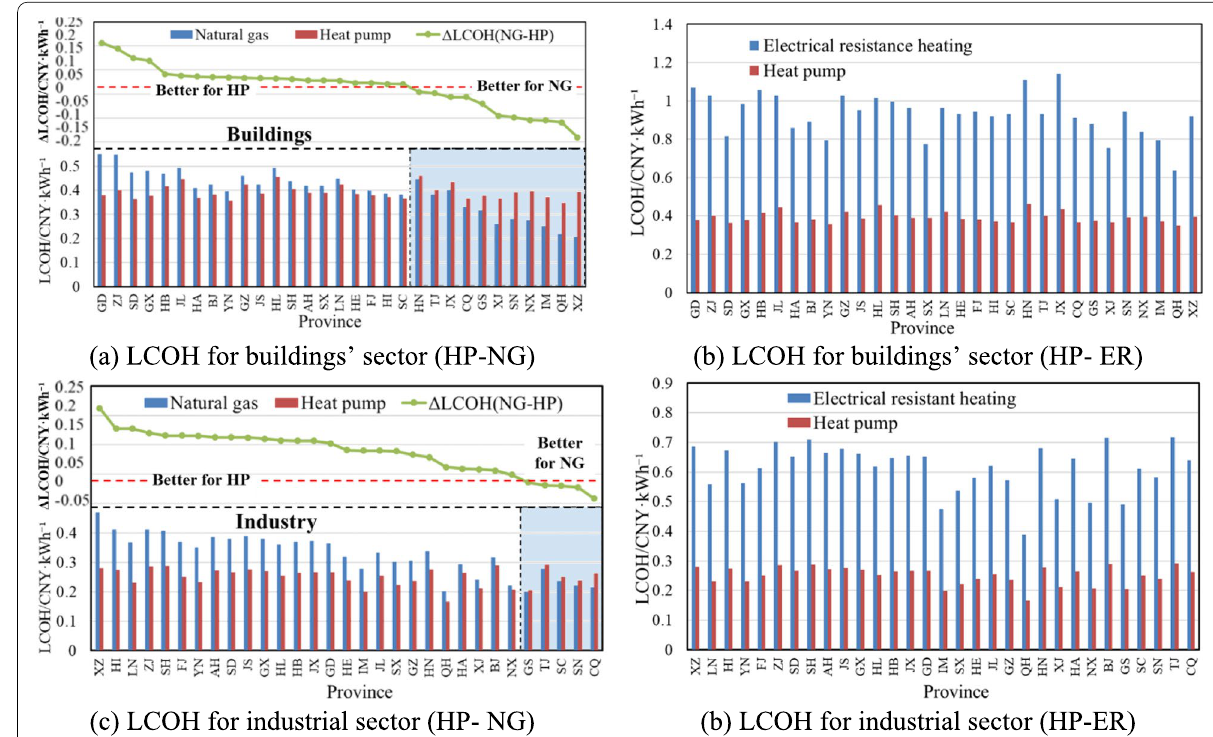
Fig. 11 Techno-economics comparison between heat pump (HP), electrical resistance heating (ER) and natural gas heating (NG) among different provinces in China’s Mainland based on the current situation. a LCOH for buildings’ sector (HP-NG). b LCOH for buildings’ sector (HP- ER). c LCOH for industrial sector (HP- NG). d LCOH for industrial sector